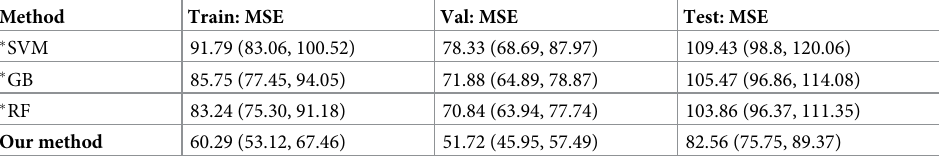
Table 5. The comparison of the MSE values of the proposed CNN method and classical machine learning methods.